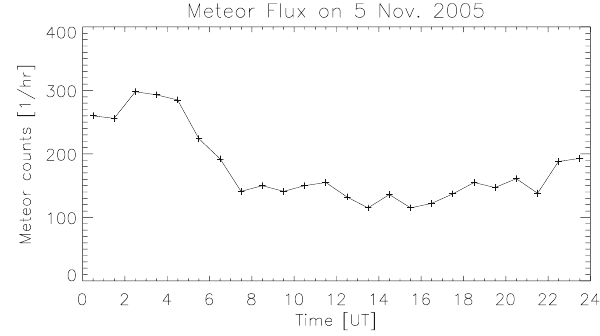
Fig. 3. The daily height profile of the meteor counts on 5 November 2005 measured over Andøya by the SKiYMET meteor radar. The dotted line shows the monthly average for November 2005.